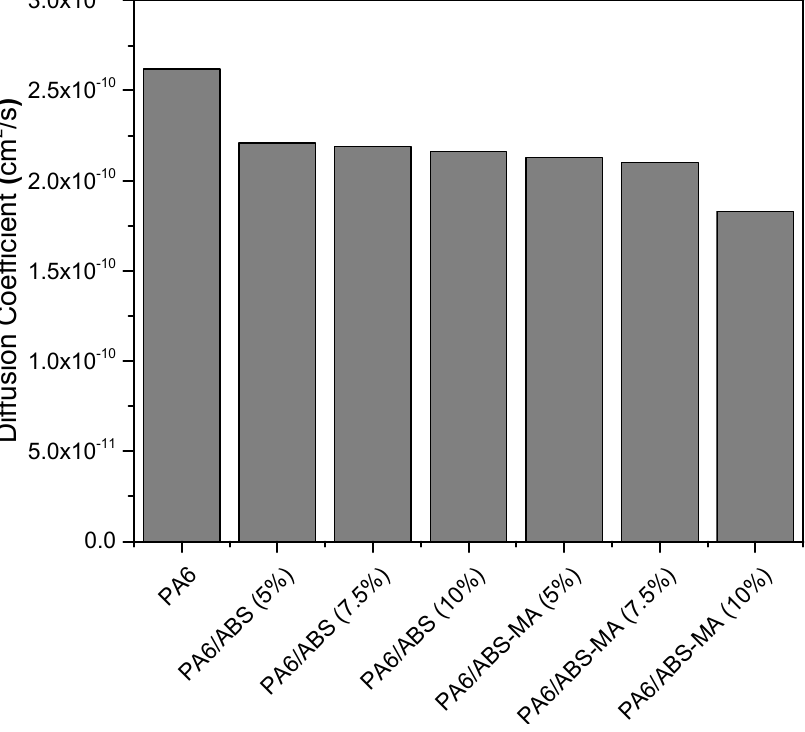
Figure 19. Water absorption on PA6 and its ABS and ABS-MA blends. Figure 20 presents the diffusion coefficient results of PA6 and its ABS and ABS-MA blends.